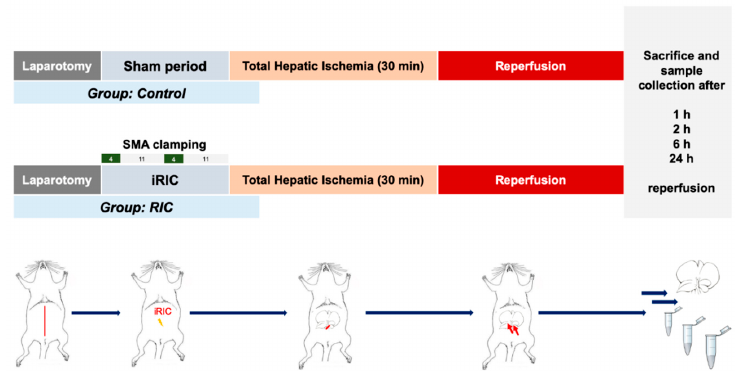
Figure 1. Study flowchart surgical protocol. Animals were randomized into two experimental groups (Control, RIC). Following laparotomy and dissection of the superior mesenteric artery (SMA) intestinal remote ischemic conditioning (iRIC) was applied as of 4-min of ischemia and 11-min of reperfusion via clamping of the SMA. Total hepatic ischemia was induced by clamping the hepatoduodenal ligament including both the portal vein and the hepatic artery. Animals were sacrificed after 1, 2, 6, 24 h of reperfusion for sample collection and further analysis ( n = 5 / group / time point). Modified